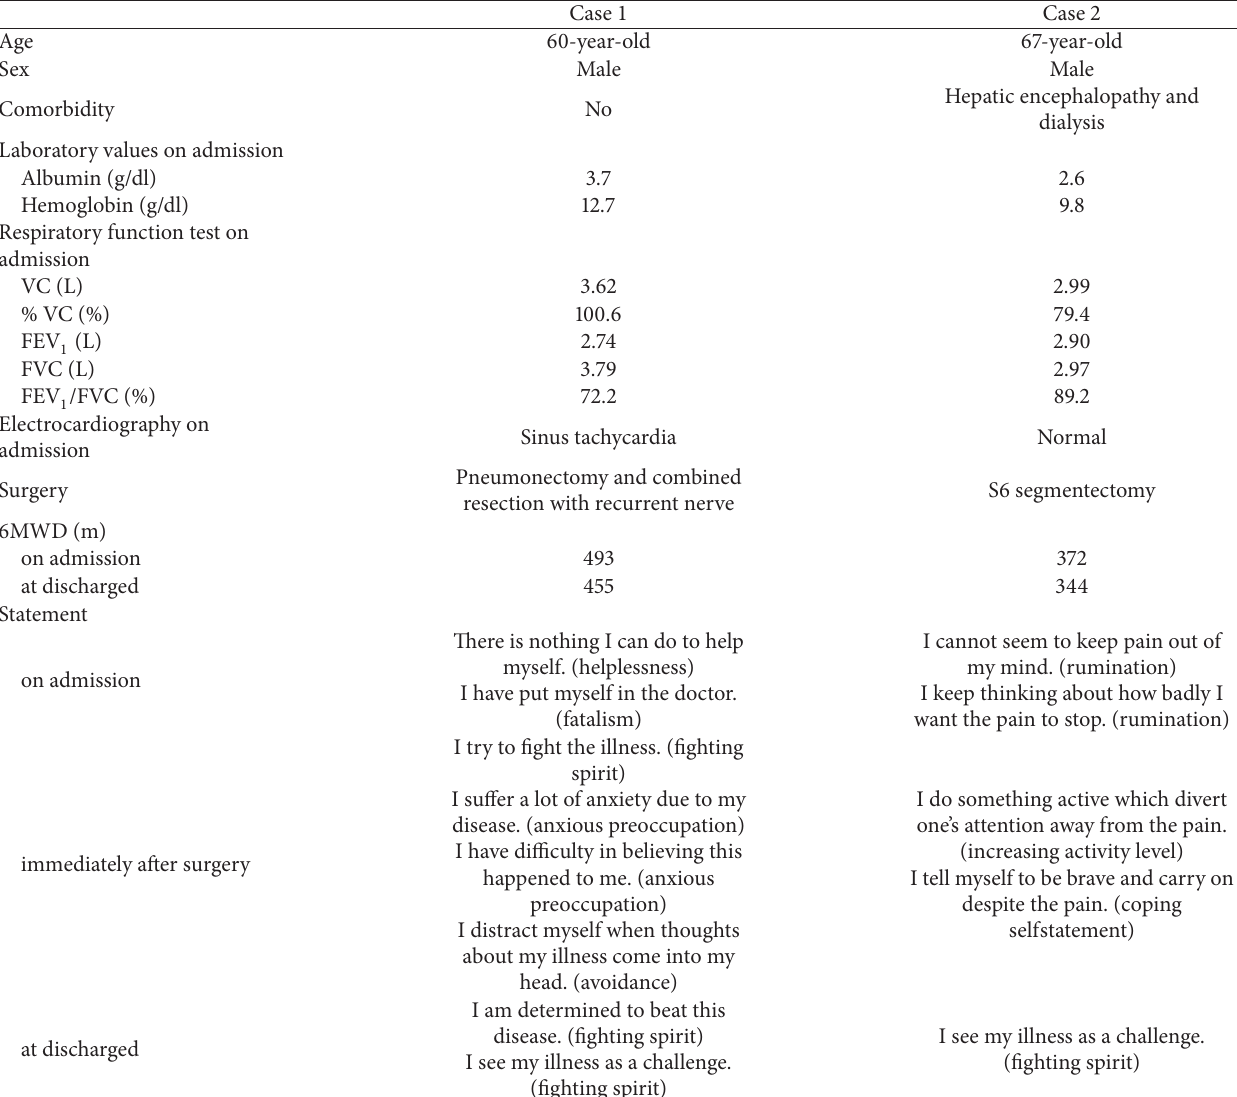
Table 1: Patient characteristics and response to